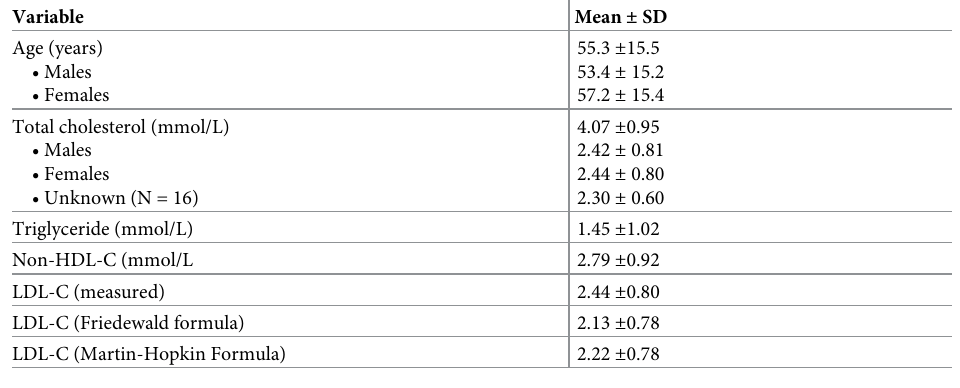
Table 1. Demographic and biochemical characteristics expressed as mean ±